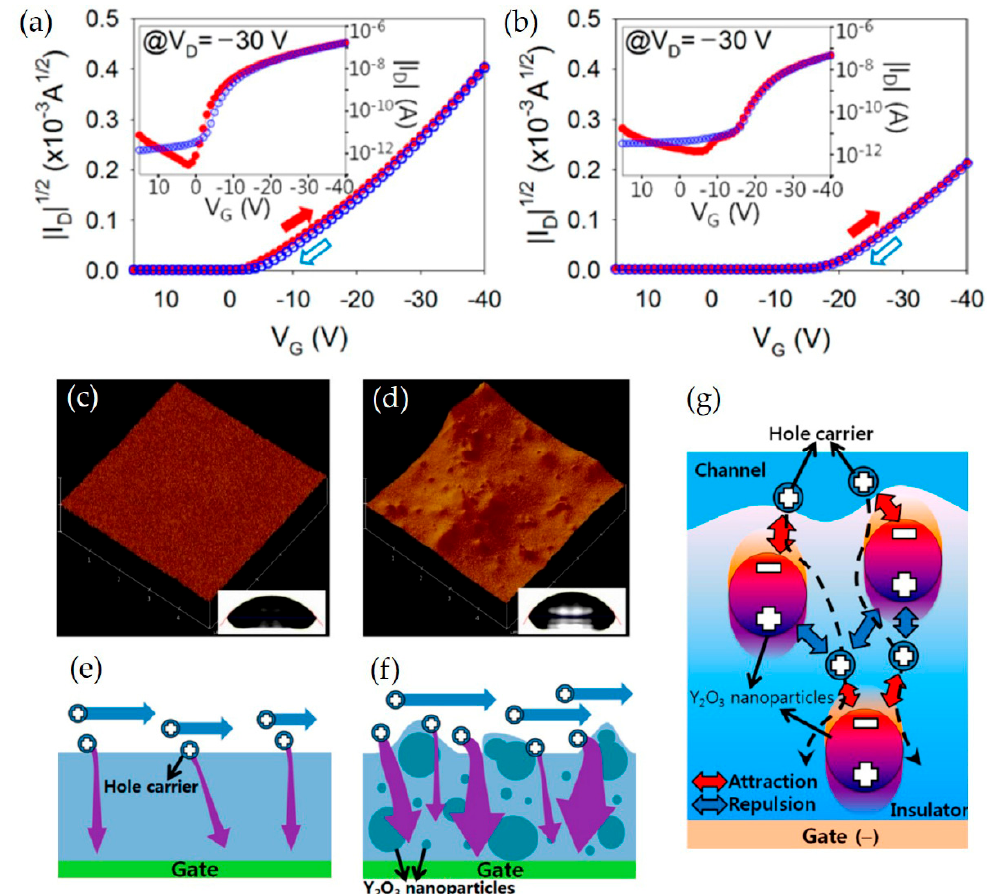
Figure 8. |I D | 1/2 vs. V G plots of TIPS-pentacene TFTs with the ( a ) c-PVP/Y 2 O 3 composite and ( b ) c-PVP gate insulators. AFM images of the ( c ) c-PVP and ( d ) c-PVP/Y 2 O 3 composite films. The insets show the contact angles on both films. Leakage current paths through the ( e ) c-PVP/Y 2 O 3 composite and ( f ) c-PVP gate insulators. ( g ) Possible interaction between the holes and the Y 2 O 3 nanoparticles in the c-PVP/Y 2 O 3 composite insulator. Reproduced with permission from [131], Copyright 2016, MDPI, Basel, Switzerland.